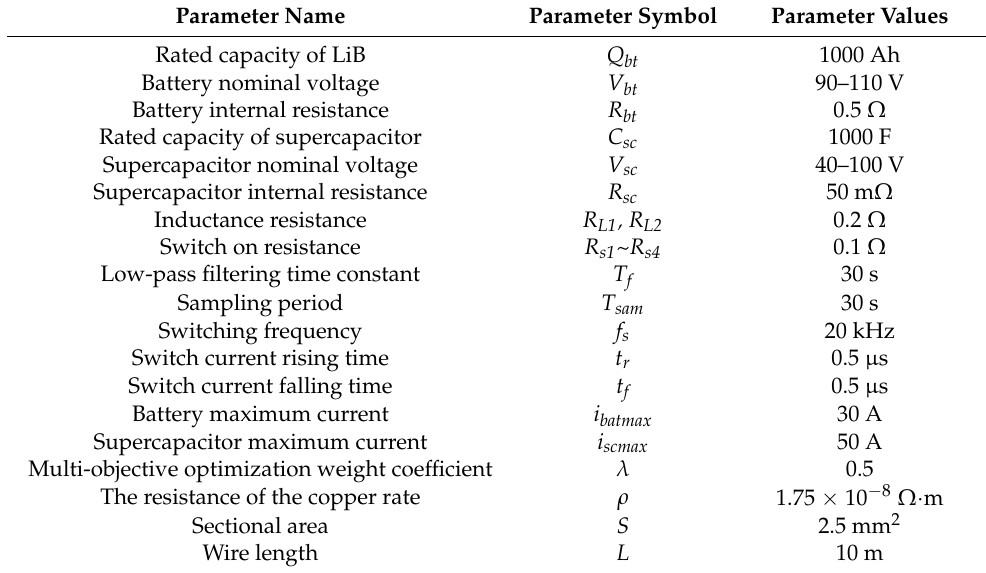
Figure 21. Typical output power and load profile in a Chinese new energy community. Table 4. HESS parameters.